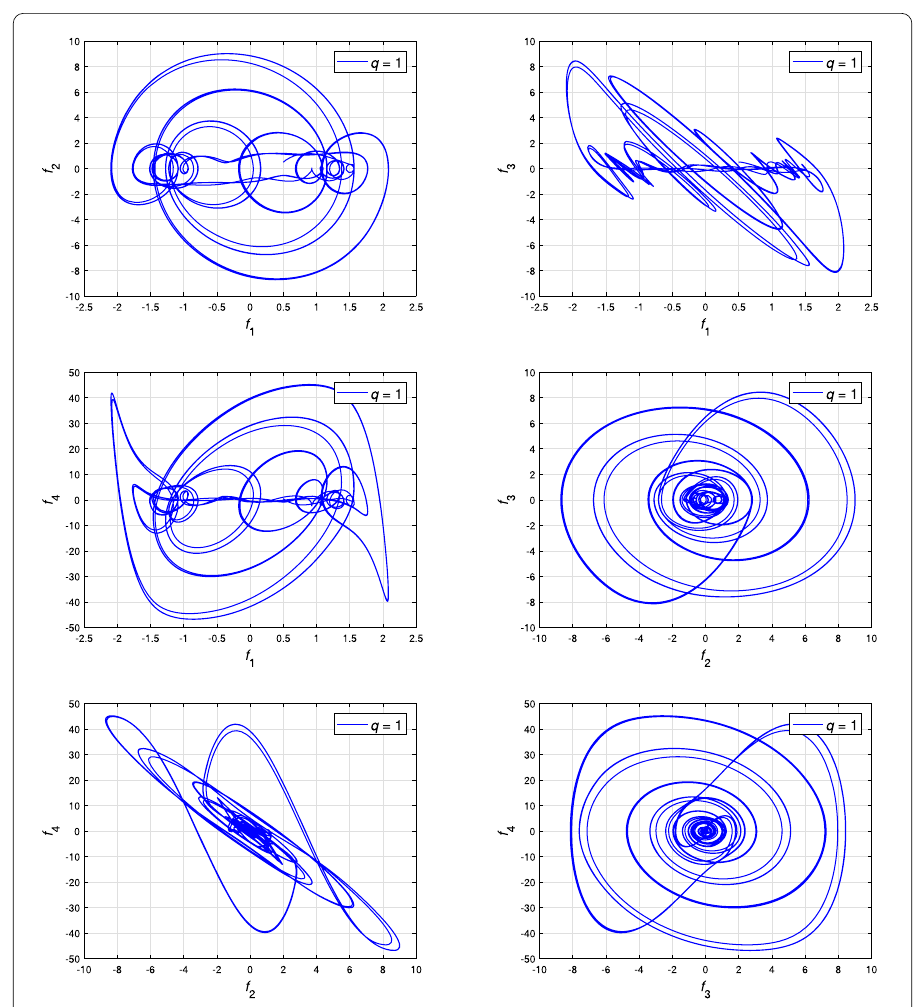
Figure 6 The phase planes of the fractional chaotic system (6) for q = 1